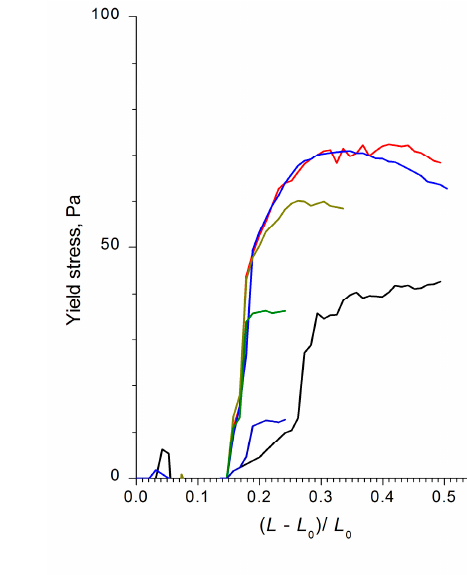
( L − L 0 ) (cid:4666)(cid:3013)(cid:2879)(cid:3013) (cid:3116) (cid:4667) at various values of the initial voltage applied. The at various values of the initial voltage applied. The L 0 (cid:3013) (cid:3116)